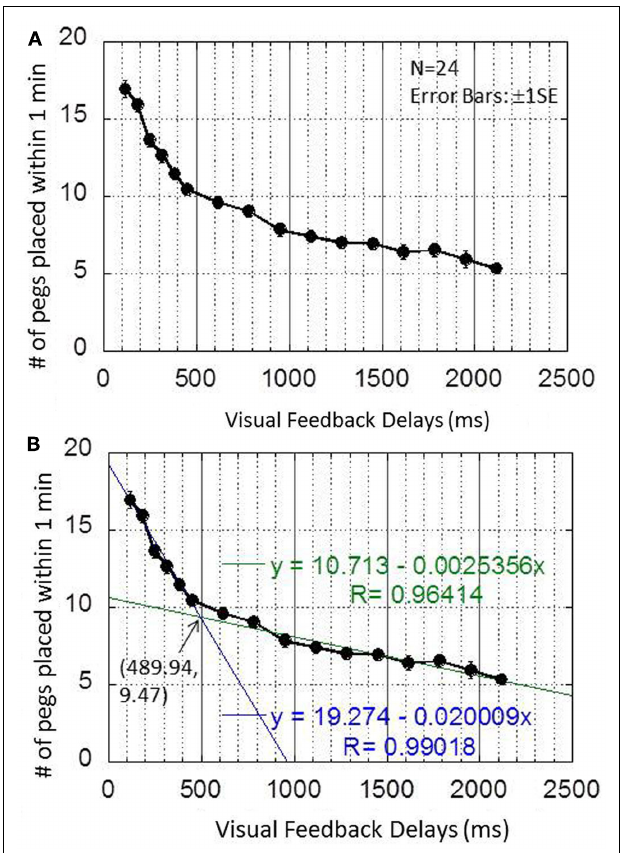
FIGURE 4 | Results obtained in experiment 1. (A) This graph plots the pegboard task as a function of the visual feedback delays from 120 to 2120ms in 16 steps. (B) This graph shows the two best-fit regression lines and their intersection